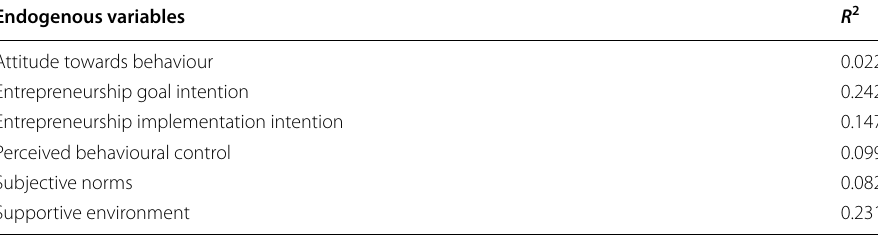
Table 4 Coefficient of determination ( R